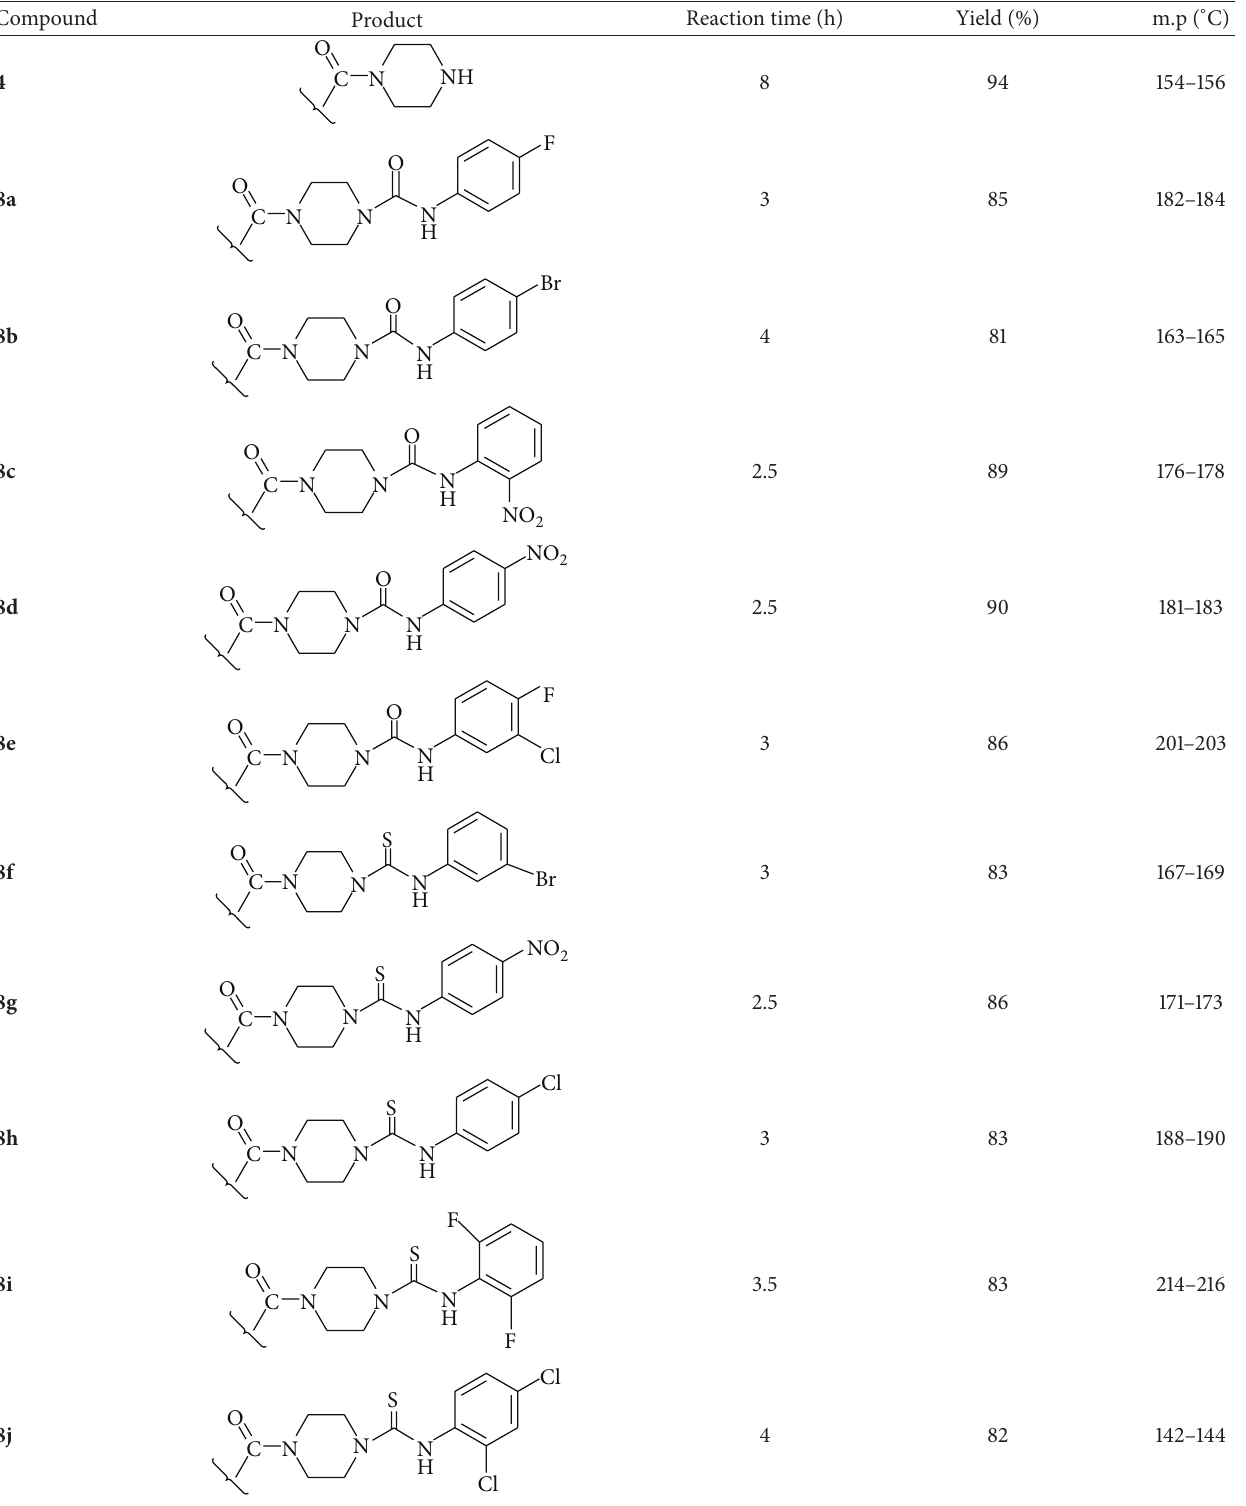
Table 1: Physical data of titled urea and thiourea derivatives 8(a–j)